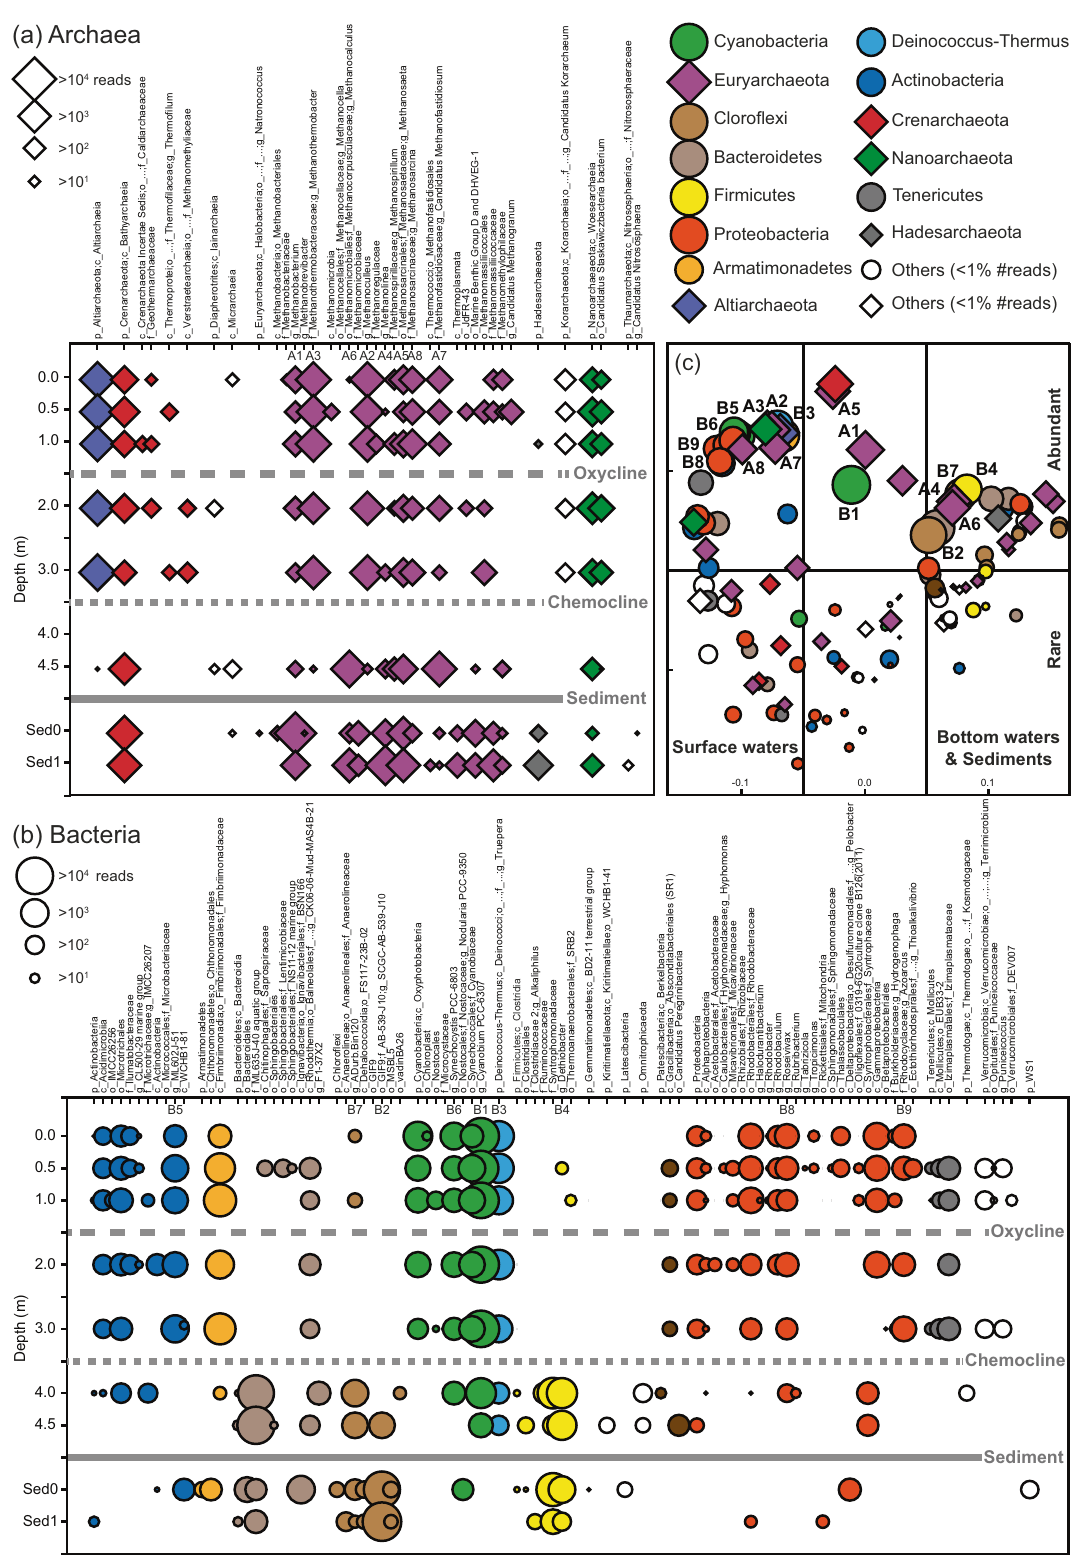
Fig. 4 Microbial community composition across the water column and sediment of Lake Sonachi. All retrieved taxa of a Archaea and b Bacteria are represented with symbol size proportional to the number of Illumina-sequencing reads. Dominant genera are ordered by letters and numbers (Archaea = A1, A2, A3, etc.; Bacteria = B1, B2, B3, etc.). c The PCoA ordination plot, based on Bray – Curtis similarity index, was used to graphically visualize preferential associations among taxa and their relative distribution within the